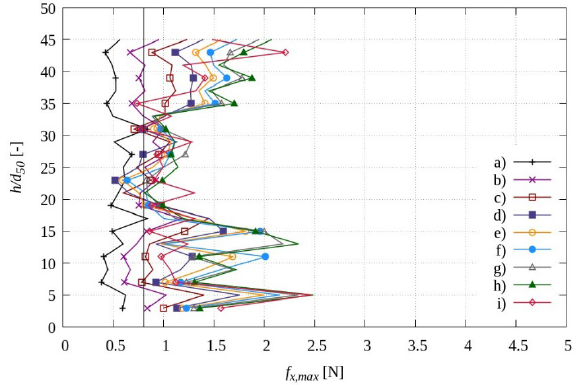
acting x, max = 0.25 mm, b) u = 0.50 x x = 1.25 mm, f) u = 1.50 x x = 10.00 mm ( e = x 0